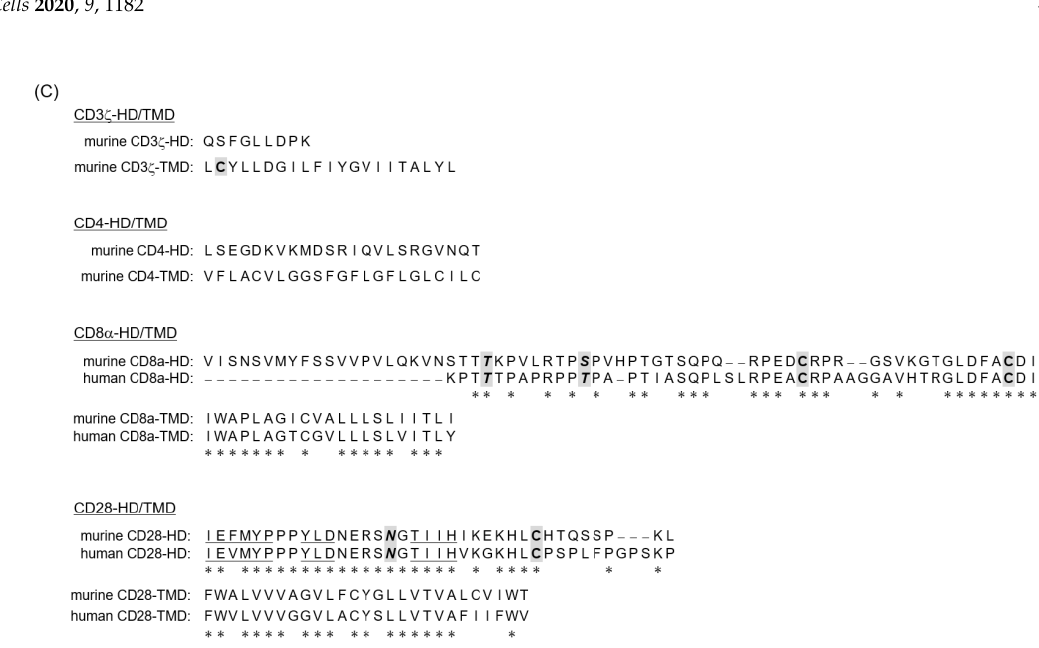
Figure 1. Illustration of vascular endothelial growth factor receptor 2 (VEGFR2)-specific chimeric antigen receptors (CARs) with hinge domain (HD) or hinge / transmembrane domains (HD / TMD) modification. ( A ) Top panel, retroviral vector constructs containing the murine VEGFR2-specific first-generation CAR genes for mouse T cells; lower panel, representation of HD-modified or HD / TMD-modified CAR proteins. The figure shows the number of amino acids (AA) used to generate HD / TMD / signal-transduction-domain (STD) and the molecular weight (MW) of each CAR. ( B ) Top panel, human VEGFR2-specific second-generation CAR mRNA constructs for human T cells; lower panel, representation of HD / TMD-modified CAR proteins. ( C ) AA sequences of CD3 ζ , CD4, CD8 α , and CD28 used for constructing the HD / TMD in this study. Cysteines that form interchain disulfide bonds are shown in bold and glycosylation sites are shown in bold italic. For CD8 α -HD / TMD and CD28-HD / TMD, sequence alignment between mouse and human is shown. An asterisk denotes an identical AA, whereas alignment gaps are indicated by a hyphen. In CD28-HD, the area that forms the β -sheet structure is underlined.